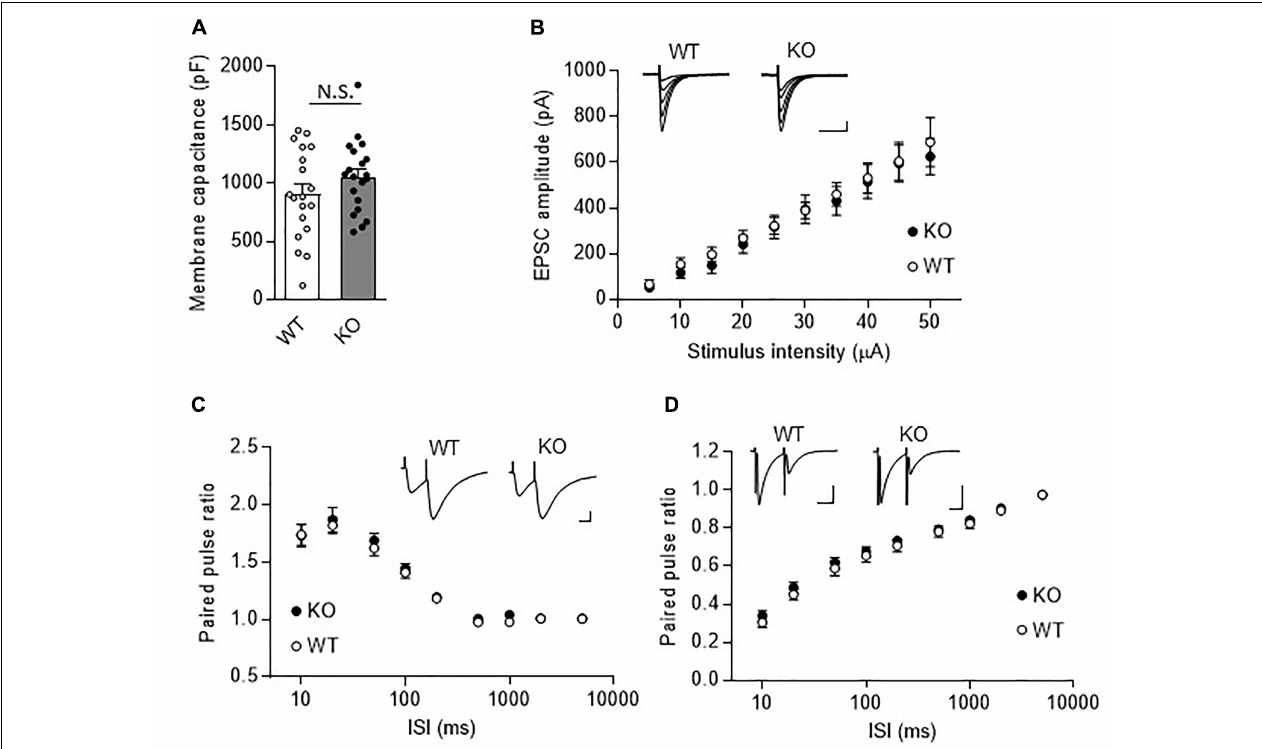
FIGURE 3 | Normal fast synaptic transmission and short-term synaptic plasticity in TRH-KO mouse PCs. (A) Membrane capacitance in PCs from TRH-KO mice and their WT littermates (KO: 20 PCs from four mice, WT: 19 PCs from four mice). N.S., no significant difference as determined using Welch’s t -test. (B) Graph depicting the average sizes of PF EPSC amplitudes against the intensity of stimulus delivered to PFs (KO: 9 PCs from four mice, WT: 10 PCs from four mice). Representative traces of EPSCs at various stimulus intensities (5–50 µ A) are presented above the graph. Scale bar: 100 pA, 50 ms. (C,D) Averaged graphs showing the PPF ratios of PF EPSCs (C) and the PPD ratios of CF EPSCs (D) determined based on the responses evoked by two stimuli with various interstimulus intervals. The PPF and PPD ratios were measured as the second EPSC amplitude normalized to the first EPSC amplitude. Representative traces for stimulation with a 20-ms interstimulus interval are presented above the graph. CF, climbing fiber; EPSC, excitatory postsynaptic current; KO, knock-out; PF, parallel fiber; PPD, paired-pulse depression; PPF, paired-pulse facilitation; WT, wild-type.